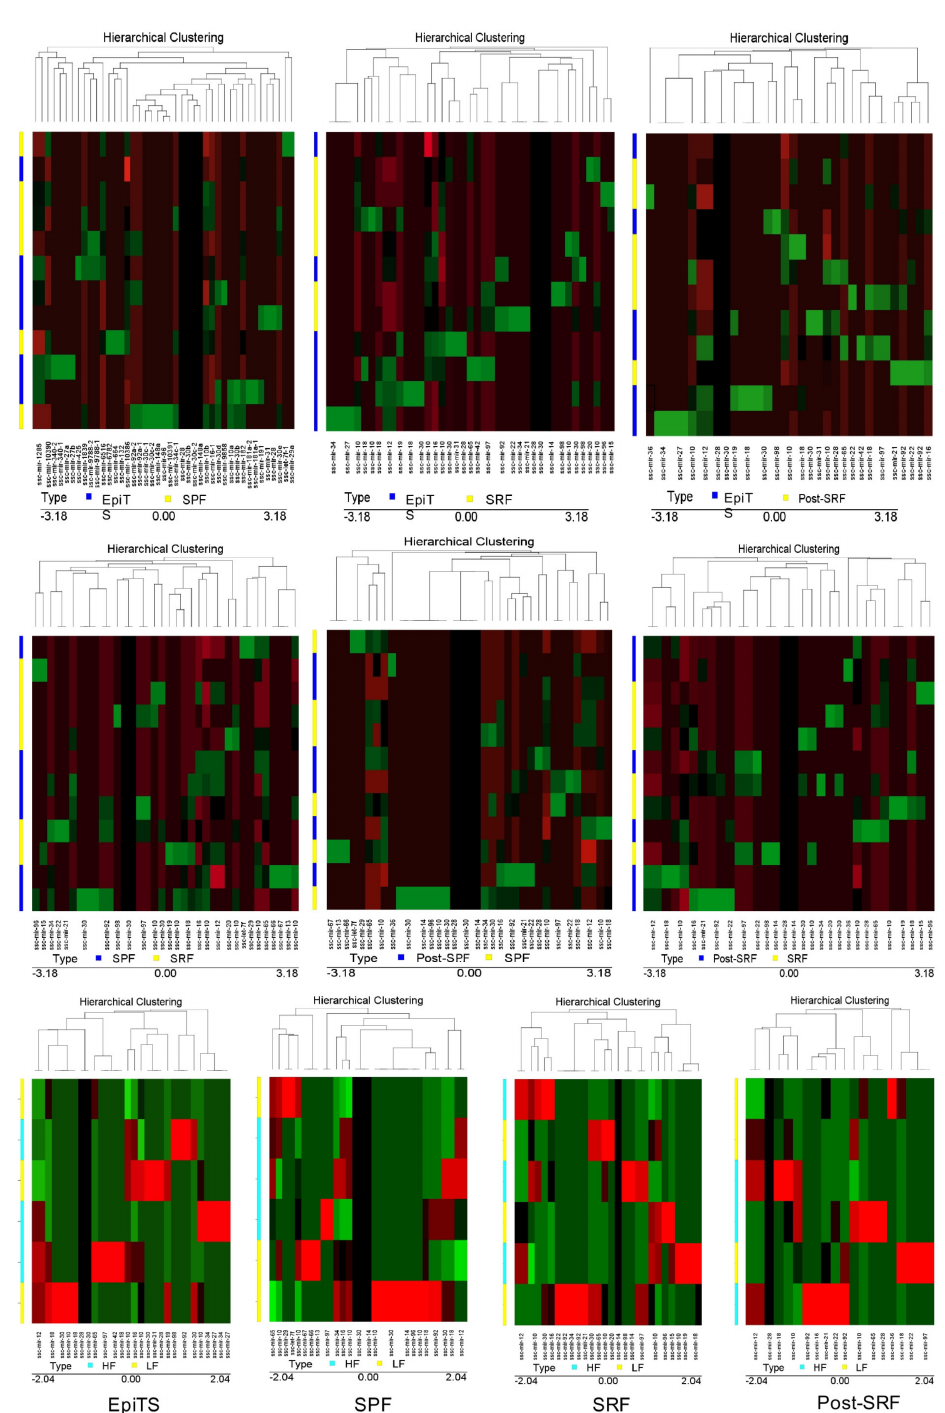
Figure 3. Hierarchical clustering of the expression levels of miRNAs identified in spermatozoa collected from the three ejaculate fractions studied (SPF: sperm-peak fraction; SRF: sperm-rich fraction; and post-SRF) and from the functional epididymal terminal segment (EpiTS) from all boars used in this study ( n = 6, upper- and mid- figures), and also, expression levels of miRNAs when selecting boars with either higher- (HF) or lower- fertility (LF) ( n = 3, lower figures). The color scale indicates the relative expression of miRNAs: the red color shows a higher expression and the green color depicts a lower expression. Each row represents one biological sample, and each column represents one